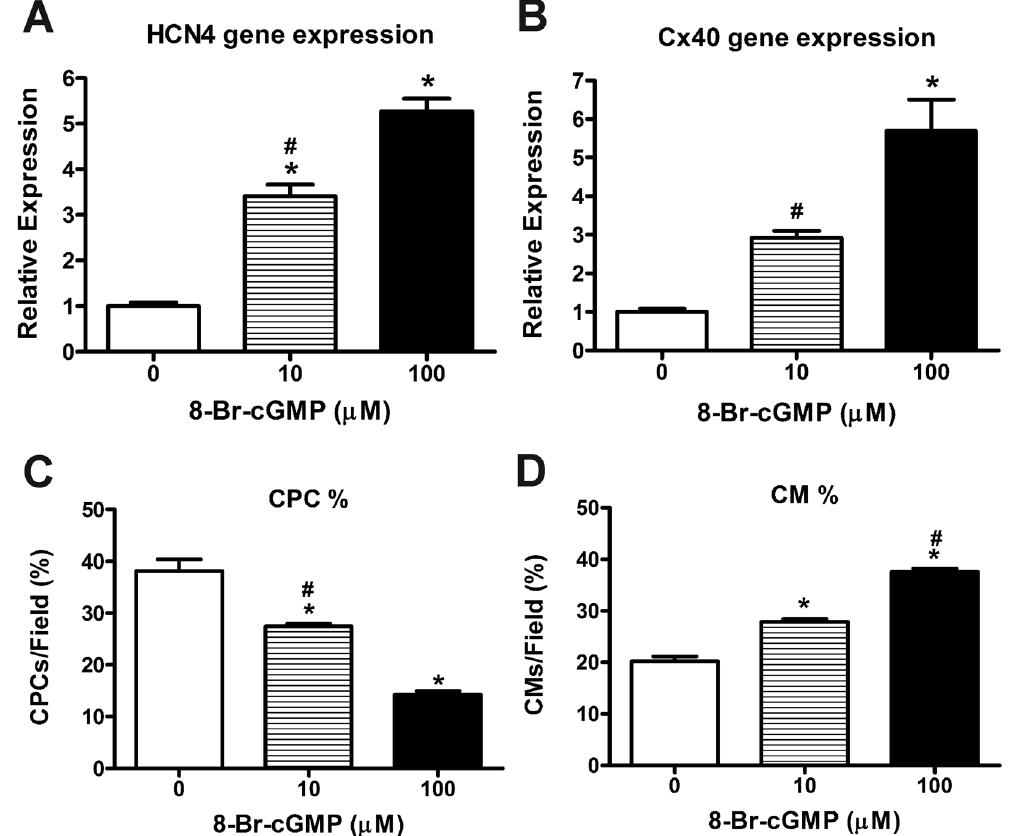
Figure 7. Effects of exogenous addition of 8-Br-cGMP on VCS marker gene expression and cell differentiation in E11.5 ventricular cell cultures: ( A , B ) RT-qPCR analysis was used to monitor HCN4 (A) and Cx40 (B) gene expression levels in cells treated with or without 8-Br-cGMP at indicated concentrations for 48 hours. Expression levels were normalized to GAPDH via ∆∆ C T method. Relative expression levels were presented as fold changes in comparison to the levels in untreated cultures (0 µ M). N = 9 independent experiments per group, each bar represents mean ± SEM, * P < 0.005 Vs. Untreated or 0 µ M, # P < 0.005 Vs. 100 µ M for panels A and B, One-way ANOVA with Tukey’s multiple comparisons post hoc test. ( C , D ) Exogenous addition of 8-Br-cGMP (10 and 100 µ M) to E11.5 ventricular cell cultures derived from a Nkx2.5-Cre and ROSA-lacZ reporter system revealed significant differences in cellular differentiation of cardiac progenitor cells (CPC) and cardiomyocytes (CM) compared to untreated cultures (0 µ M). N = 6 independent experiments. Each bar represents mean ± SEM. * P < 0.05 Vs. 0 µ M for both CPC and CM percentages, # P < 0.005 Vs. 10 µ M for CM (D) or 100 µ M for CPC (C), One-way ANOVA with Tukey post hoc